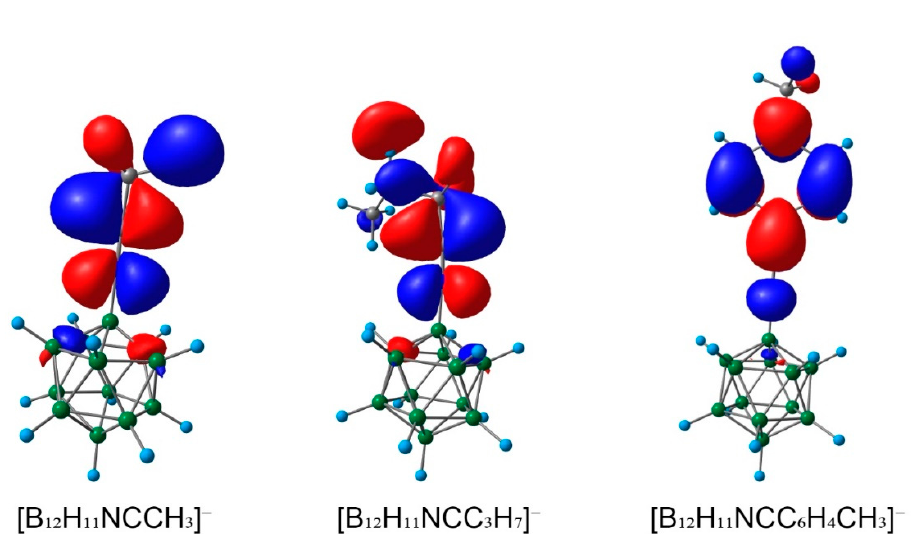
Figure 5. LUMO of nitrilium derivatives [B 12 H 11 NCR] − , R = CH 3 , n -C 3 H 7 , 4-CH 3 C 6 H 4 .